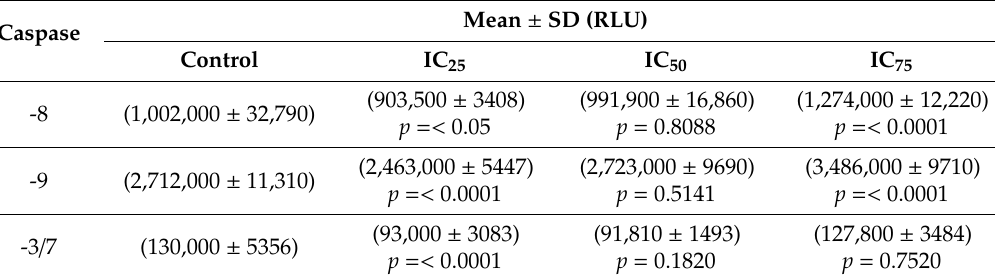
Figure 6. The effect of TA on initiator caspases ( A, B ) and executioner caspases ( C ) in Hek-293 cells. Both ( A ) caspase-8 and ( B ). caspase-9 were downregulated at IC 25 and IC 50 treatments, whilst IC 75 treatments significantly increased initiator caspase activation relative to the control. ( C ) Caspase 3/7 were downregulated at all treatments as compared to the control (*** p < 0.0001 ) . Data is expressed as relative fold-change. Table 1. Caspase activity in tannic acid (TA) treated Hek-293 cells.